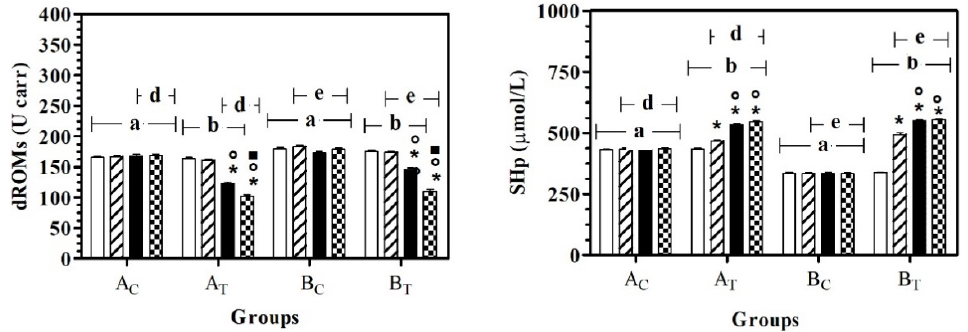
Figure 1. Mean ± standard deviation (SD) of dROMs and SHp recorded for the different data points